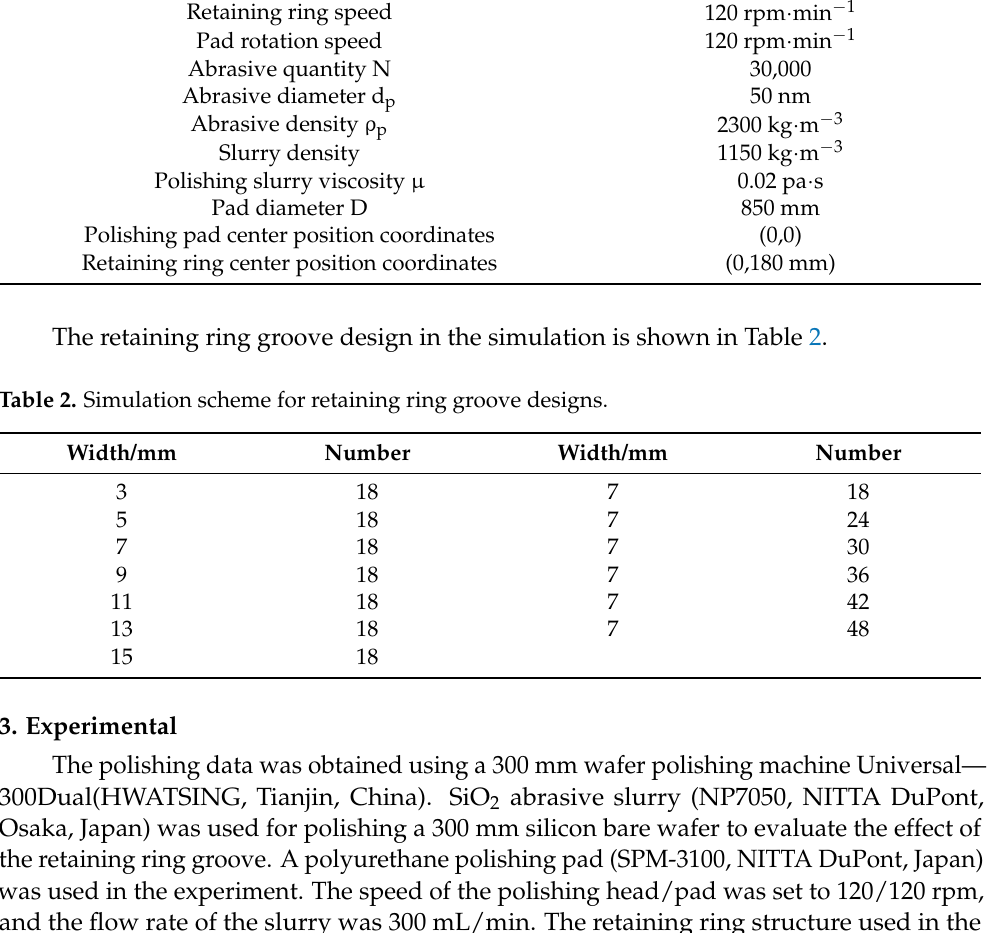
Table 1. Parameters used in the simulation model .